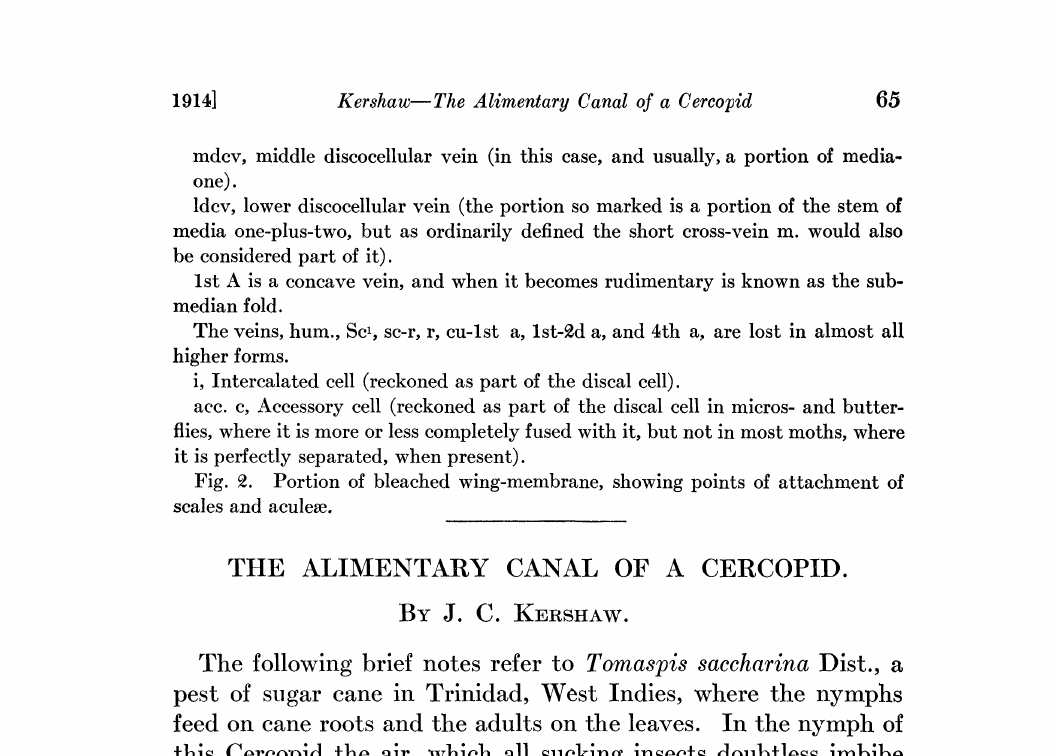
. Fig. Portion of bleached wing-membrane, showing points of attachment of scales and